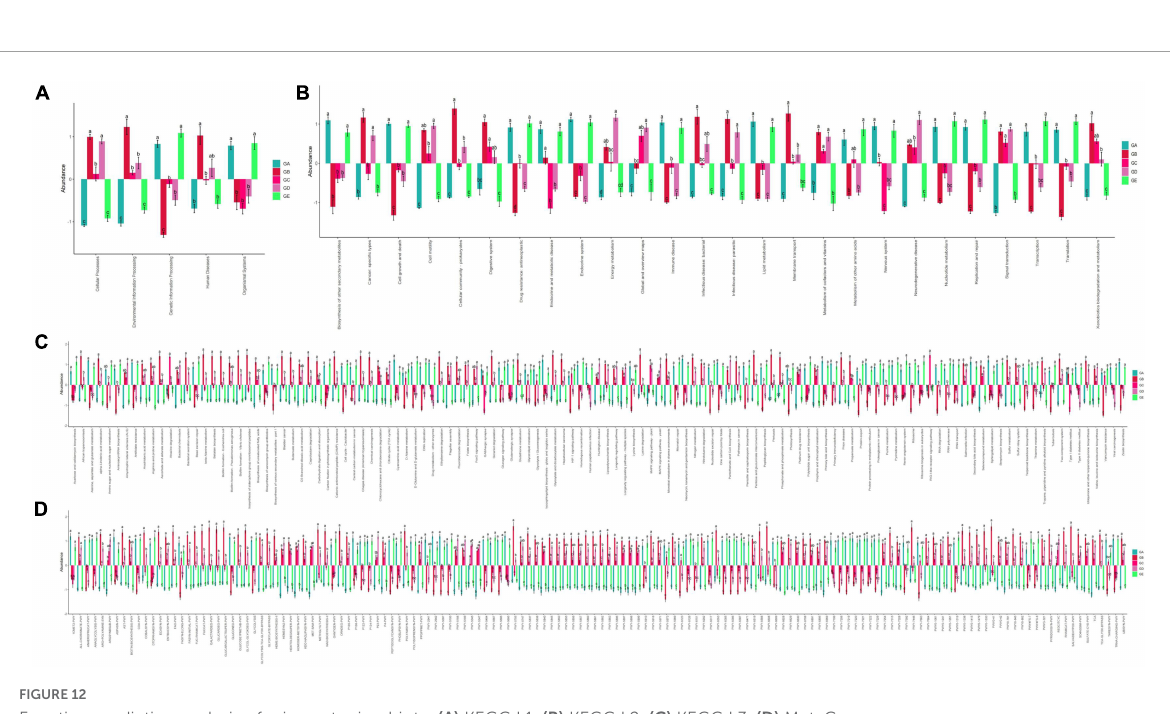
FIGURE12 Function predicting analysis of mice gut microbiota. (A) KEGG L1, (B) KEGG L2, (C) KEGG L3, (D)